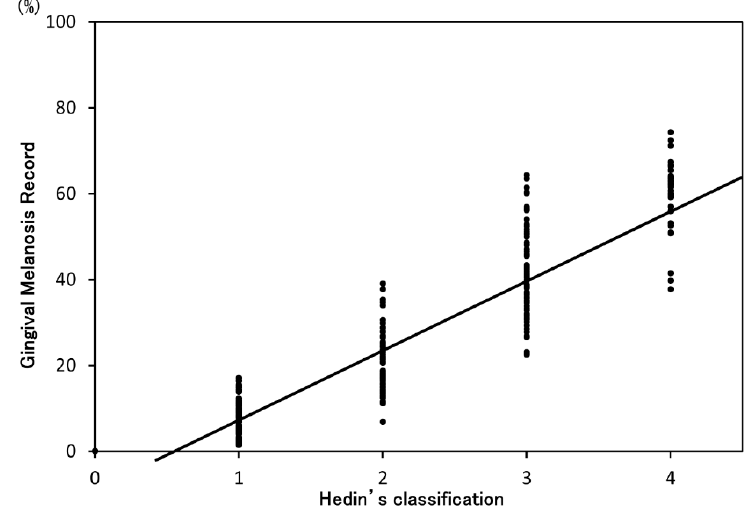
Figure 3. Scatter diagram of the GMR and Hedin’s classification. Table 2. Validation of the GMR and Hedin’s classification (ICC (1,1) and ICC (2,1)).